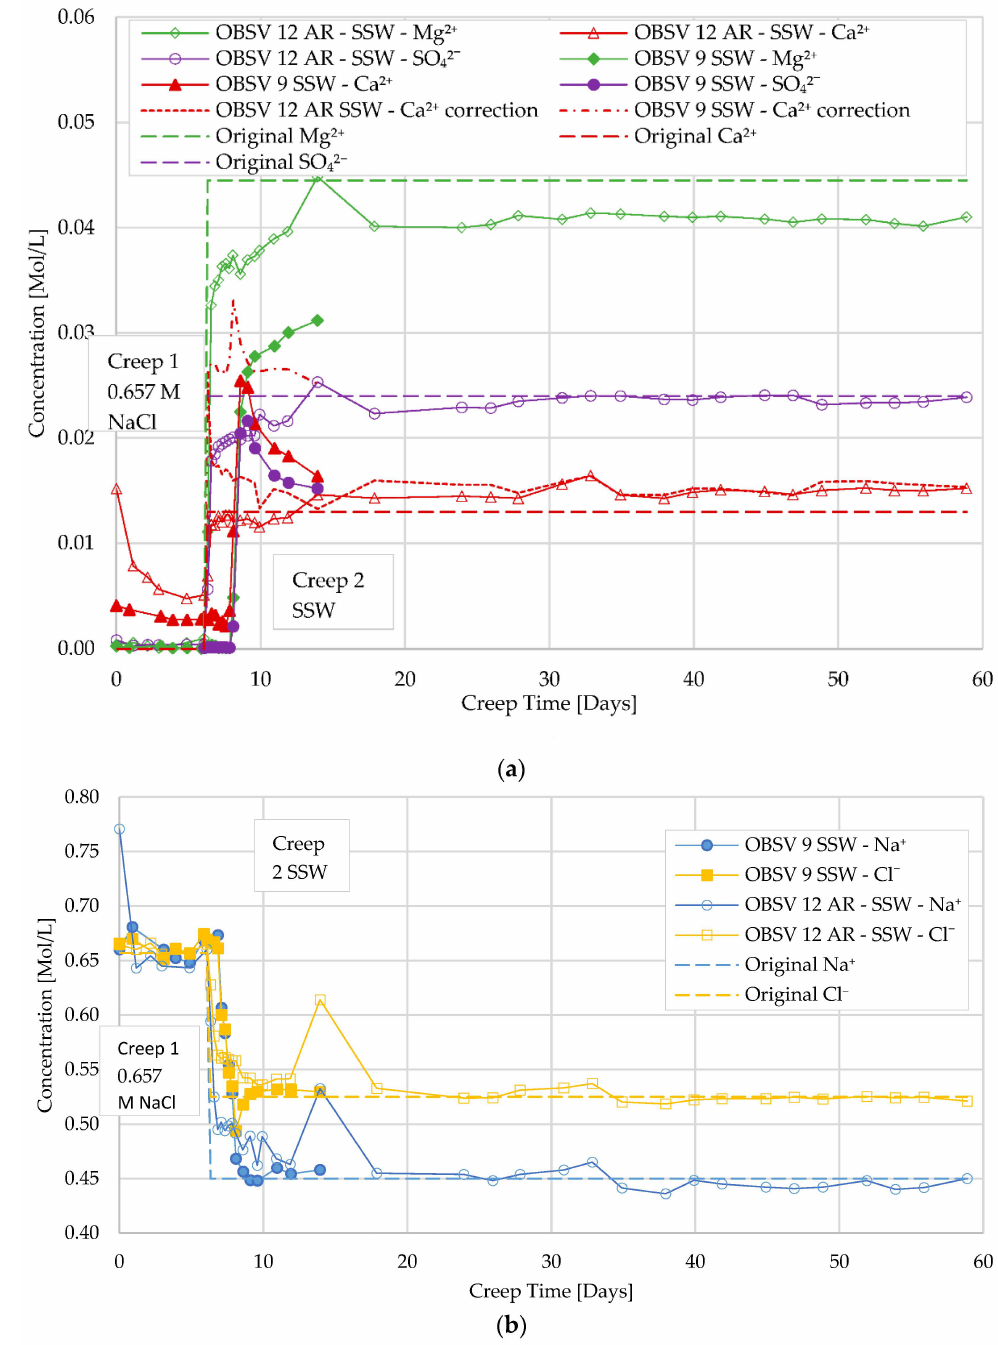
Figure 5. Effluent data for OBSV 9 SSW and OBSV 12 AF-SSW: ( a ) Mg 2+ , Ca 2+ , and SO 42 − concentra- tions for the intact and artificially fractured sample flooded with SSW (OBSV 9 SSW and OBSV 12 AF-SSW) Ca 2+ correction reflects potential Ca 2+ production without anhydrite (CaSO 4 ) precipitation. ( b ) Effluent data for Na + and Cl − is presented for samples as in Figure